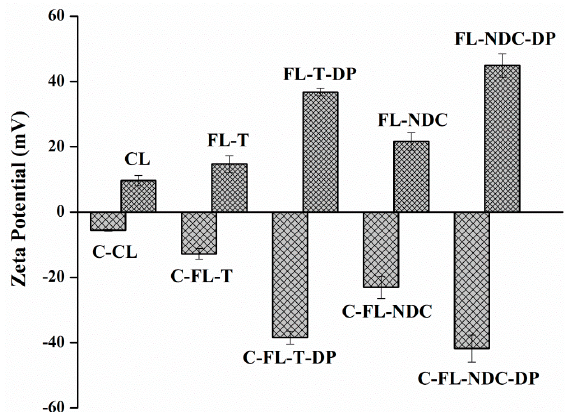
Figure 1. Zeta potentials of docetaxel (DXT)-loaded (5 mg/mL) liposomes and chitosomes. The data are expressed as means ± SD, n = 3. CL—conventional liposome; FL—flexible liposome; T—Tween-80; DP—dicetyl phosphate; NDC—sodium deoxycholate; C—chitosan-coated (0.5 mg/mL).